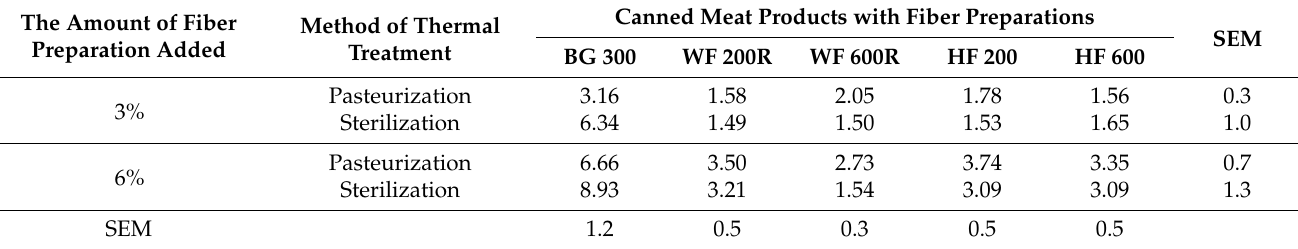
Table 3. Absolute color difference ( ∆